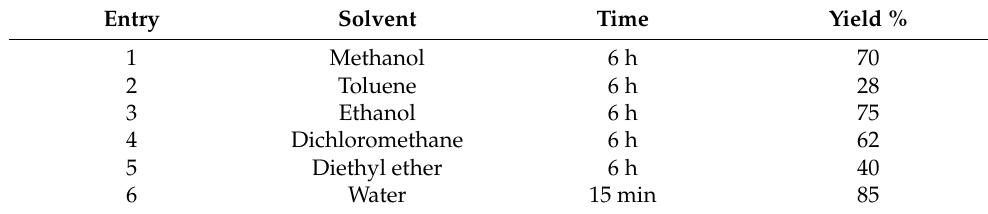
Table 1. Effect of solvents on the scope of reaction.